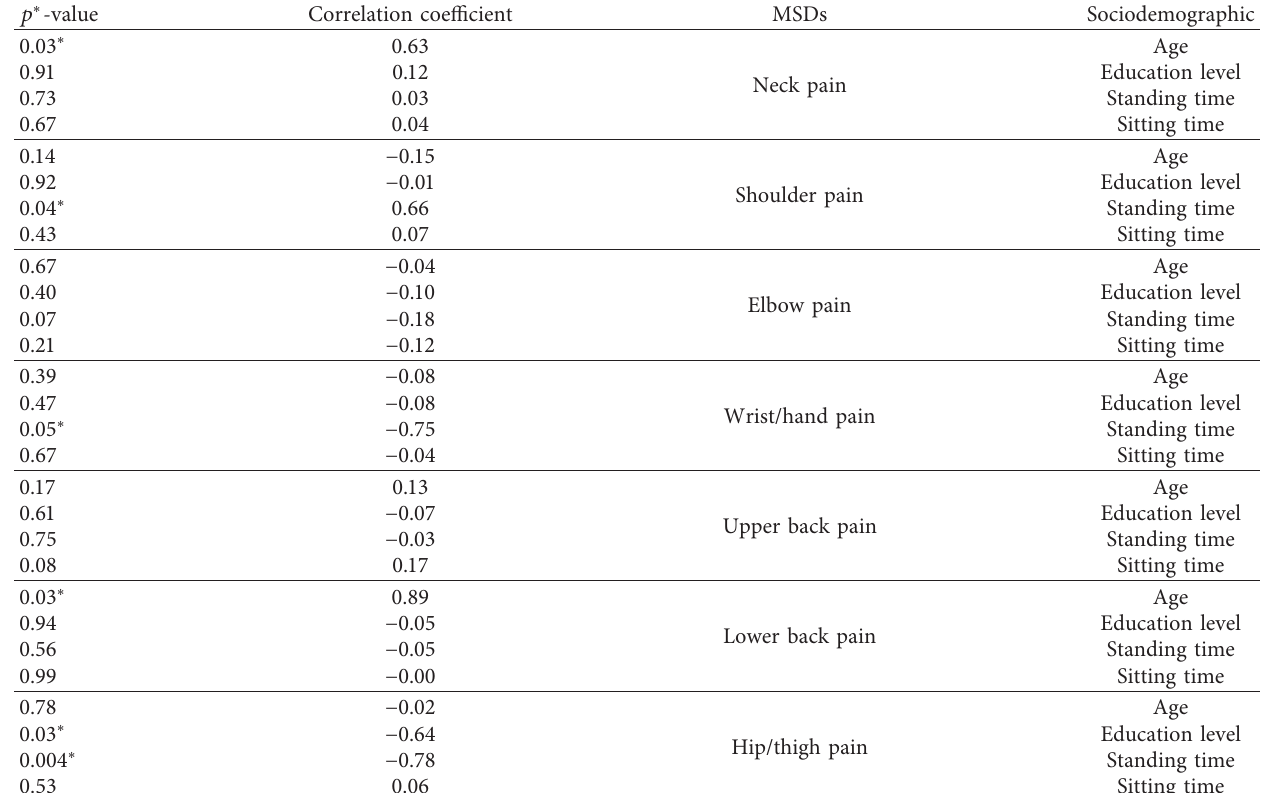
Table 5: Association of sociodemographic related to MSDs among critical care